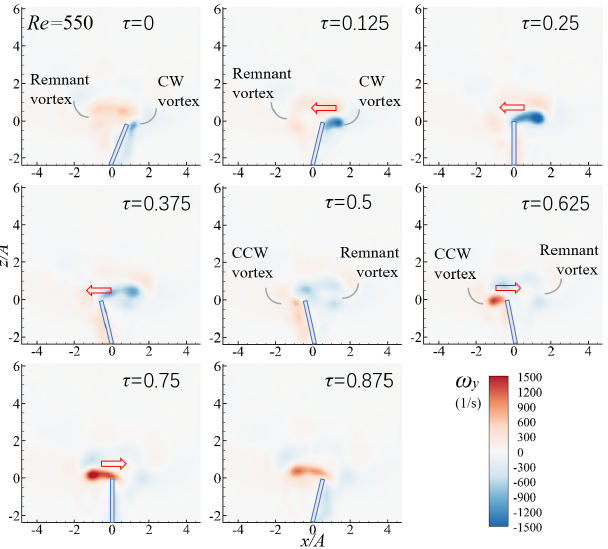
Figure 10. Evolution of y -component of vorticity ( ω y ) in one cycle at Reynolds number Re = 550.